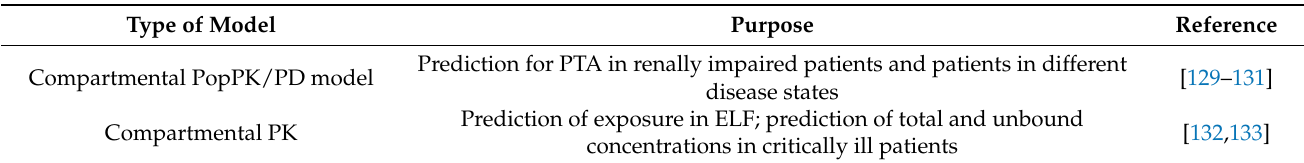
Table 3. PK/PD models used for